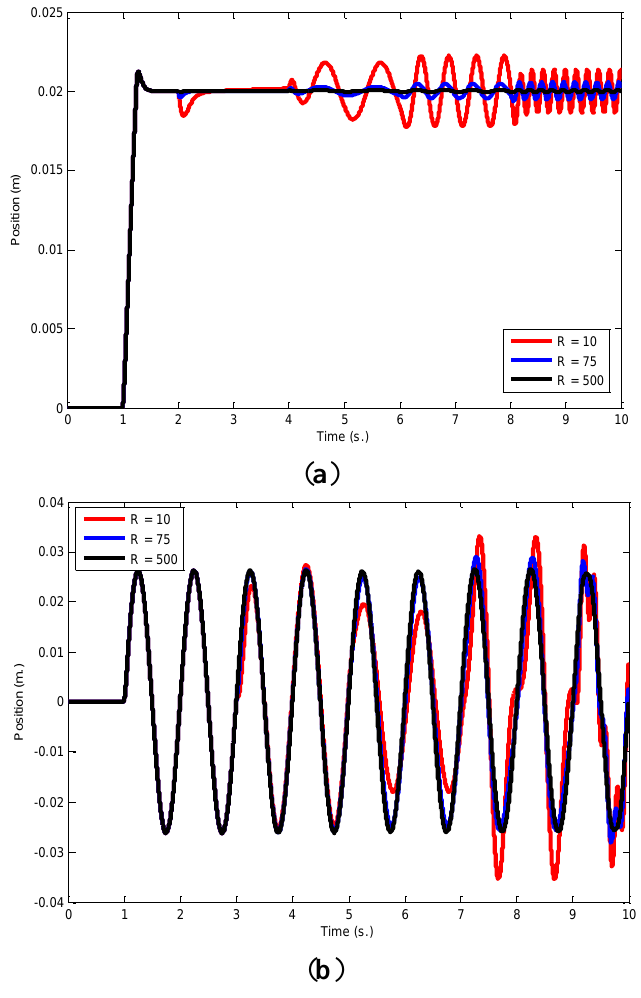
Figure 8. Position control responses when the proposed PID controller is used with different values of robustness design parameter R for ramp and sinusoidal reference inputs.